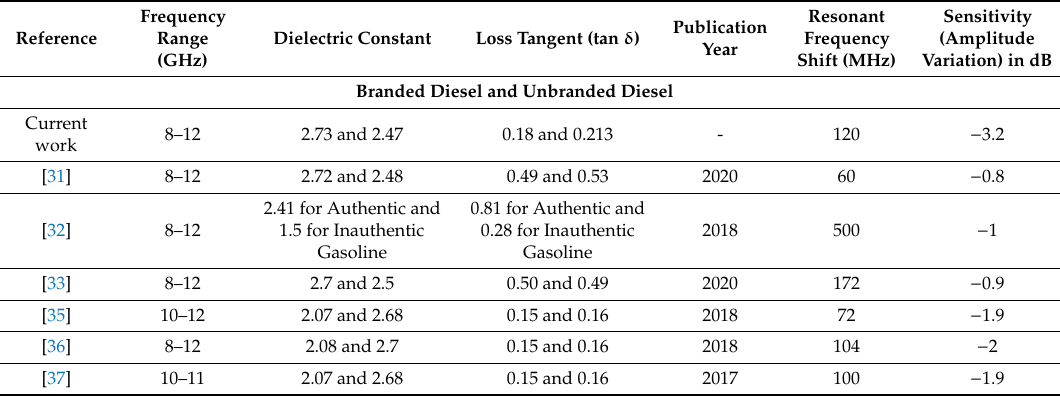
Table 3. Comparison of frequency range, dielectric constant, loss tangent, variation of transmission coe ffi cient, and resonant frequency shift with other similar studies published in